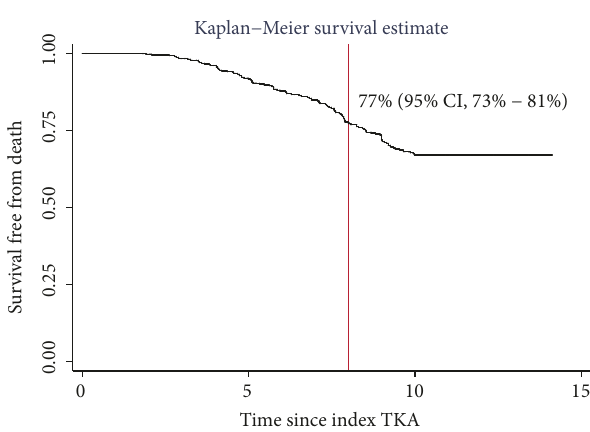
Figure 5: A Kaplan–Meier survival curve with death as failure.